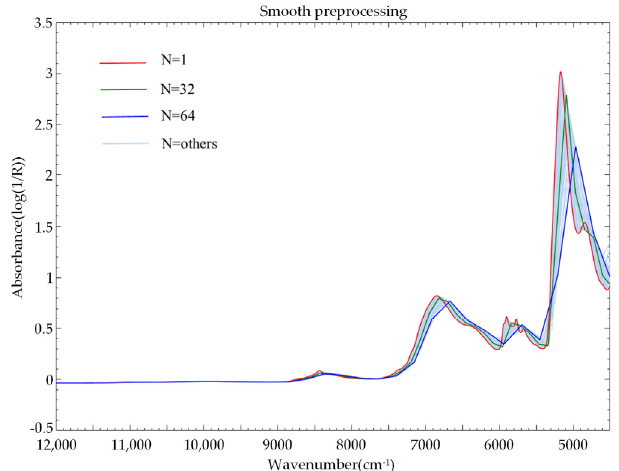
Figure 4. Evolution of the smoothing preprocessing spectrum with the smoothing window.